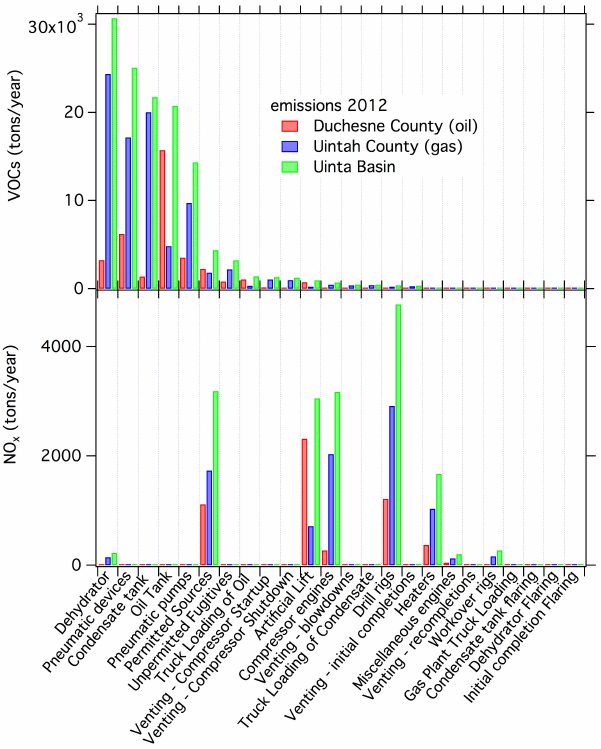
Figure 12. Total emissions of VOCs and NO x as estimated from the Uintah Basin emission inventory (WRAP inventory) by source category for Uintah and Duchesne counties and the Uintah Basin.